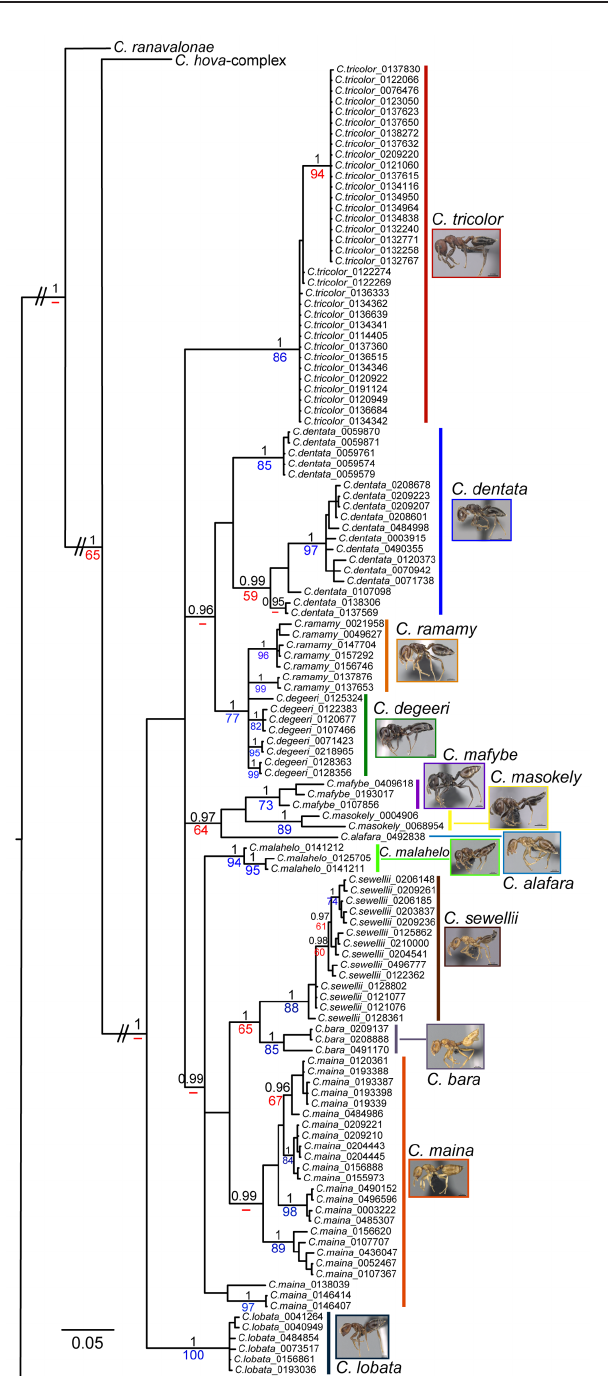
Fig. 1. Mitochondrial phylogeny of species in the Crematogaster degeeri -assemblage. Results of Bayesian inference based on 592 bp of COI, summarized as a consensus tree in MrBayes. Support values in black represent posterior probabilities (pp), those in blue ML (Maximum Likelihood) bootstrap values > 70, and those in red ML bootstrap values < 70. Values pp < 0.96 are not shown; nodes not present in the ML analysis are represented by a dash instead of a bootstrap value. The scale bar shows nucleotide changes per base pair. Long branches subtending the outgroup taxa C. madecassa Emery, 1895, C. ranavalonae Forel, 1887 and C. hova -complex have been shortened. Appended numbers on taxon labels represent CASENT#’s of respective voucher